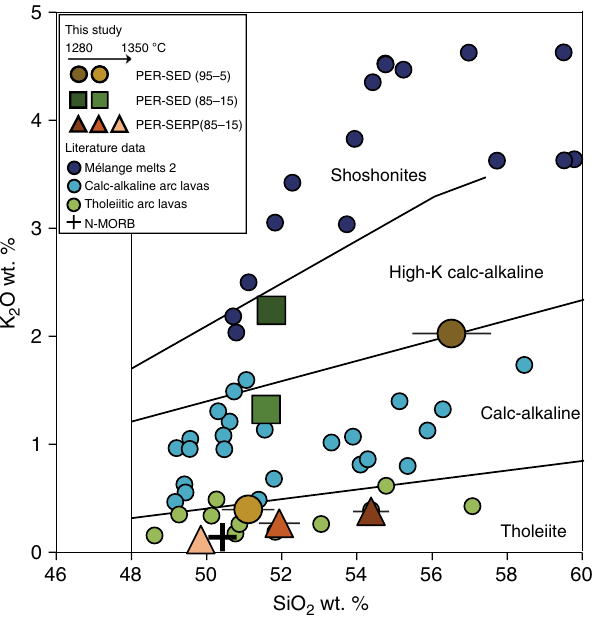
Fig. 5 SiO 2 -K 2 O diagram highlighting primitive arc magma types and experimental melts from this study. The experimental peridotite-mélange melts from this study are plotted compared to primitive calc-alkaline arc magmas 33 (light blue circles), primitive tholeiitic arc magmas 33 (green circles) and experimental melts of a pure sediment-dominated mélange material (i.e., no interaction with peridotite) of Cruz-Uribe et al. 40 (dark blue circles). Our experiments are plotted as averages with error bars representing 1 s.d. All the data, including the literature, are plotted on volatile-free basis. The average N-MORB value is from Gale et al.